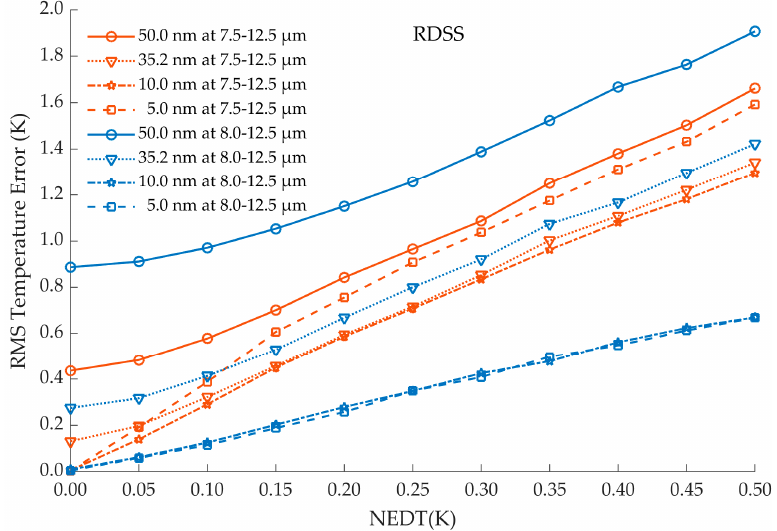
Figure 5. The plot of resolution-degrade-based spectral smoothness (RDSS) algorithm LST inversion errors varying with NEDT, spectral range and spectral resolution.